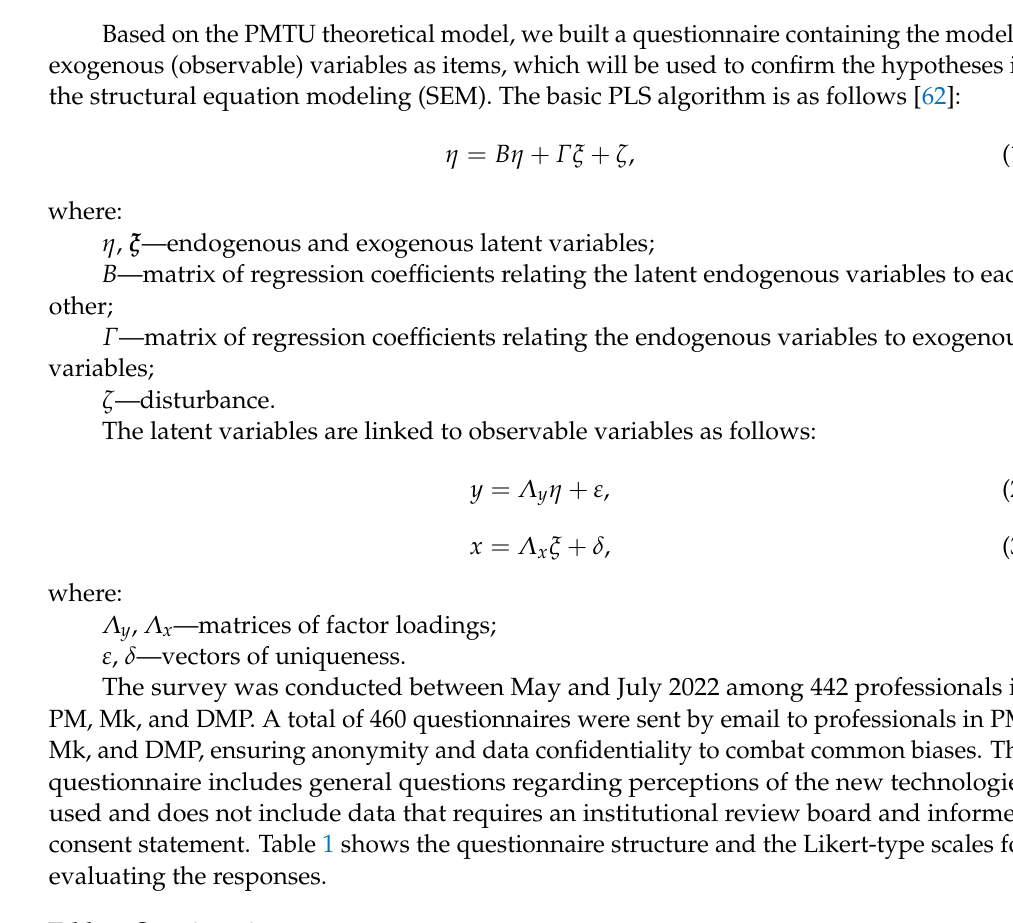
Table 1. Questionnaire